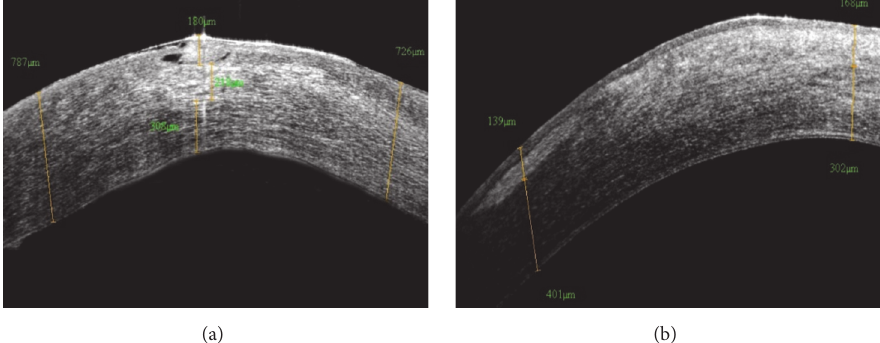
Figure 4: (a) The ulcer was shown to involve approximately 1/3 of the corneal stroma, with stromal edema and infiltration. (b) The combined surgery healed the ulcer, leaving a semitransparent and highly reflective region in the cornea at 2 months